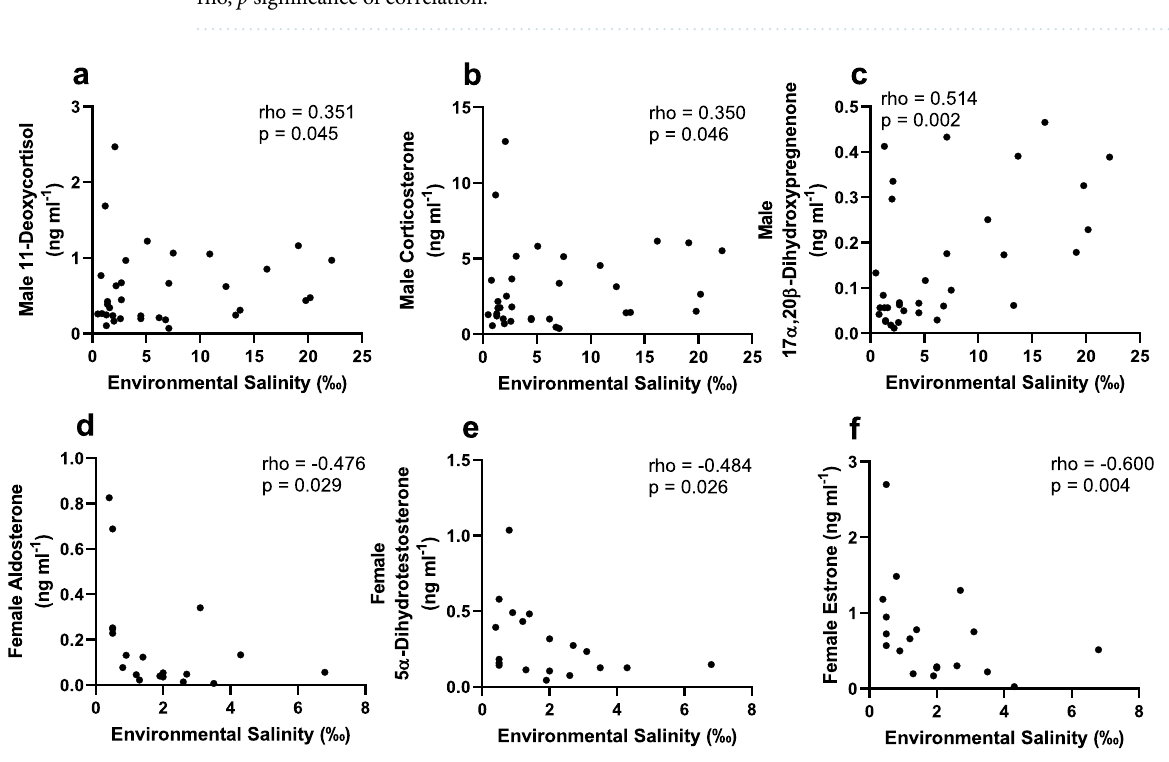
Figure 5. Spearman rank correlation between environmental salinity and plasma hormone levels found to be significant (p < 0.05) in juvenile male ( a – c ) and juvenile female ( d – f ) American alligators ( Alligator mississippiensis ). rho Spearman’s rho, p significance of